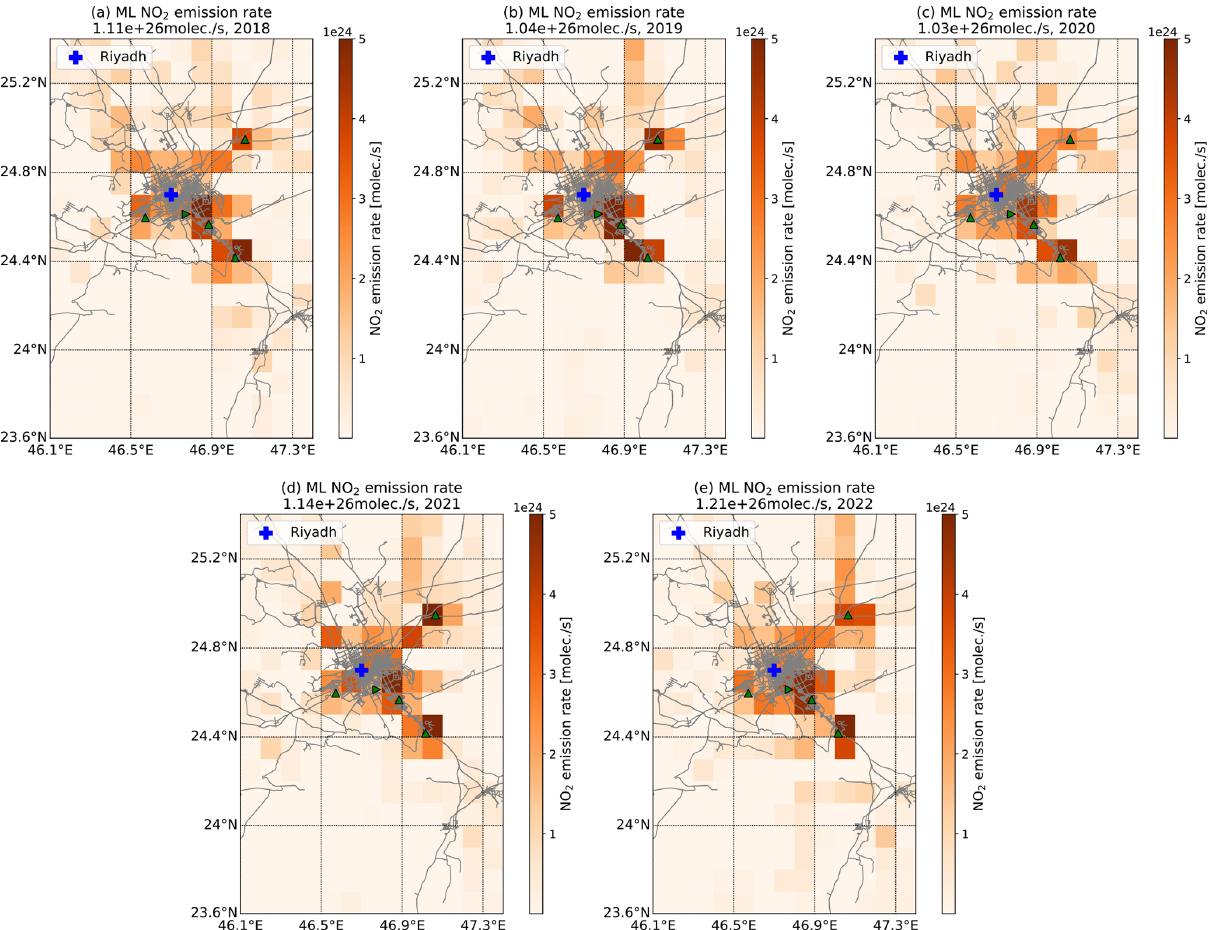
Figure A4. Yearly averaged estimated NO 2 emission rates in Riyadh for the years 2018 to 2022. Note that data in 2018 started from May and data in 2022 ended in